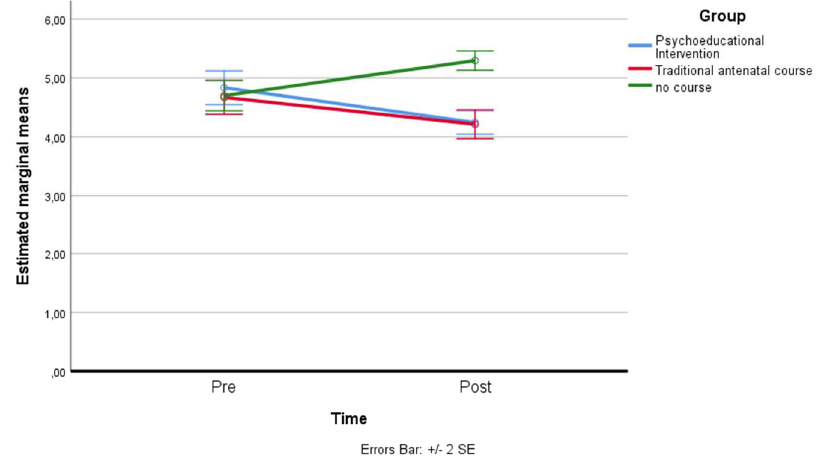
Figure 9. Estimated marginal means of future focus.